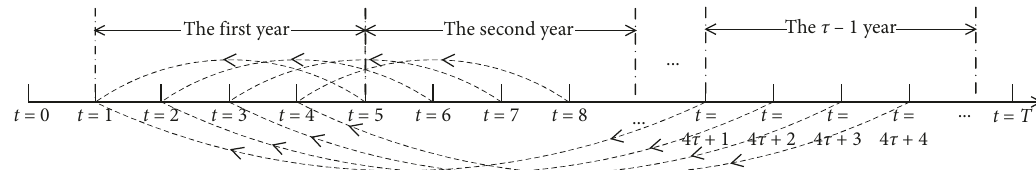
Figure 4: Illustration of stage reduction by aggregating the random factors of the same